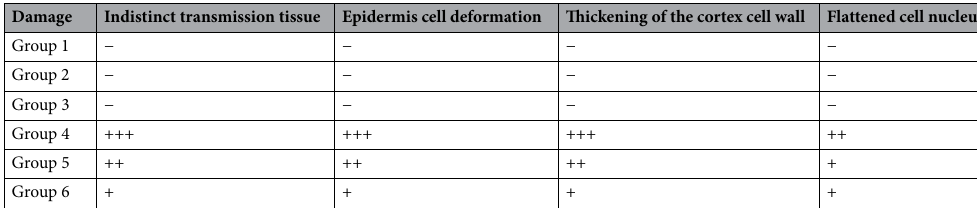
Table 5. Effects of diniconazole and CME applications on meristematic cells. *Group 1: control, Group 2: 0.5 g/L CME, Group 3: 1.0 g/L CME, Group 4: 100 mg/L diniconazole, Group 5: 0.5 g/L CME + 100